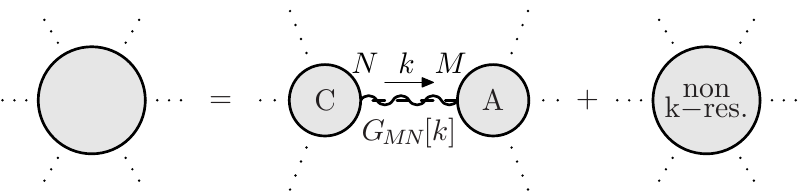
Figure 2: The decomposition of a generic scattering amplitude into resonant and non- resonant diagrams, for a given intermediate vector boson line with momentum k . Remember that (as, e.g., for Dirac fields) the momentum flows from the second towards the first index of the